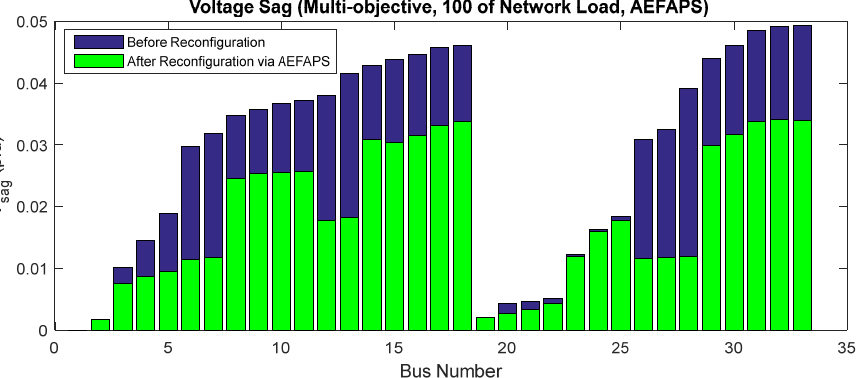
Figure 10. Voltage sag variations for an unbalanced 33-bus network using AEFAPS before and after many-criteria reconfiguration (nominal load).